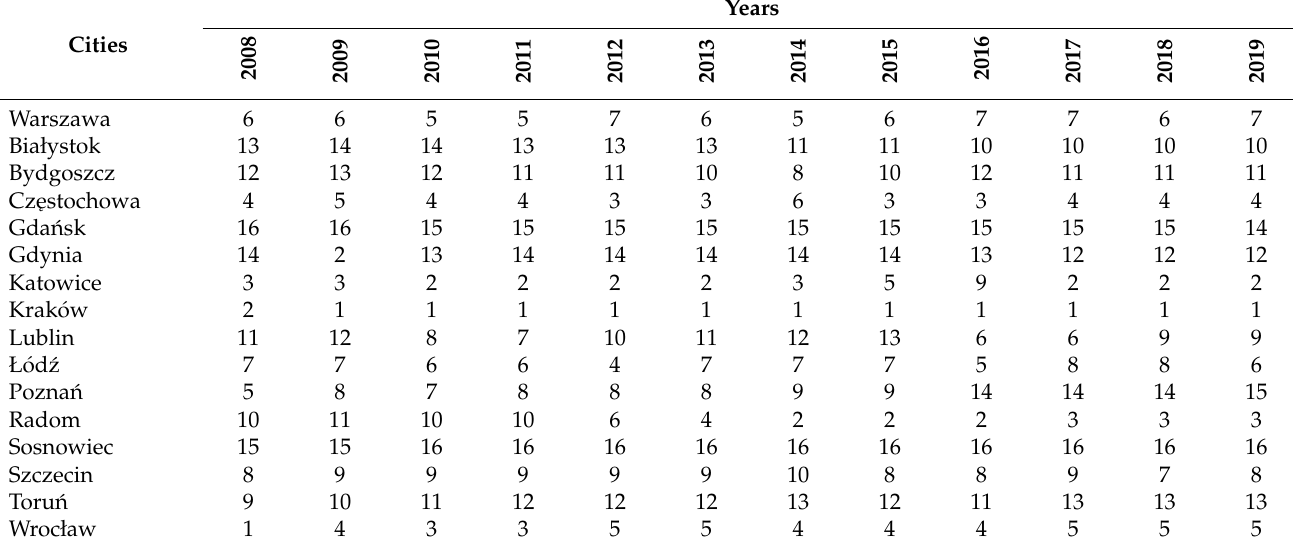
Table 1. Rankings of large cities in Poland according to their attractiveness for marketplace trade development in 2008–2019. Source: own